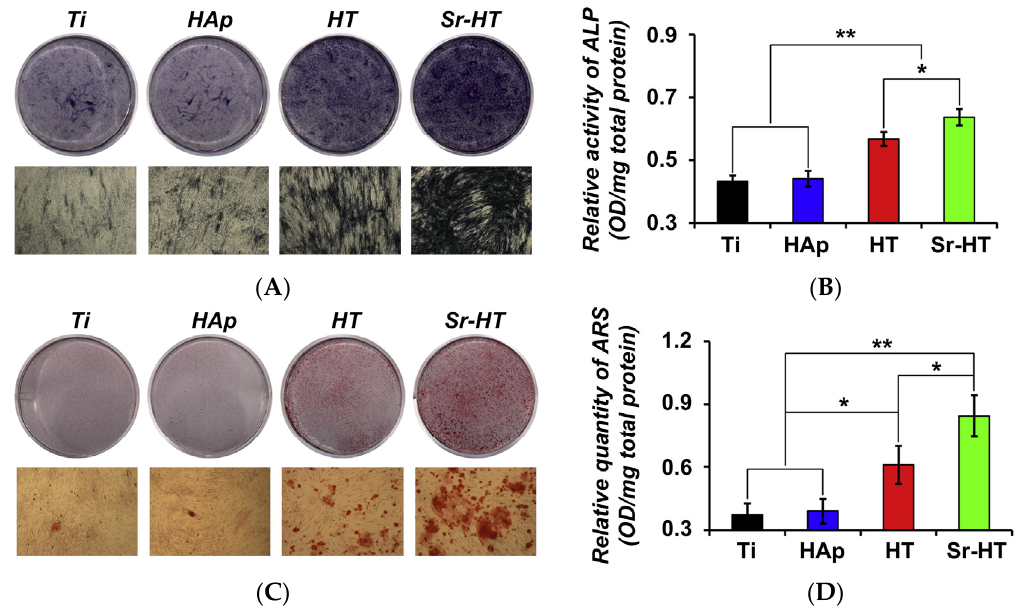
Figure 10. Extracts of Ti-6Al-4V samples coated with Sr-hardystonite enhanced the osteogenic activity of bone marrow-derived mesenchymal stem cells compared to extracts of hardystonite-coated and hydroxyapatite-coated samples, as shown by ( A ) alkaline phosphatase staining; ( B ) quantitative analysis of alkaline phosphatase activity; ( C ) Alizarin Red S staining; and ( D ) quantitative analysis of calcium deposition activity [141]. (* p < 0.05; ** p < 0.01). Reproduced by permission of Elsevier, Copyright © 2013.